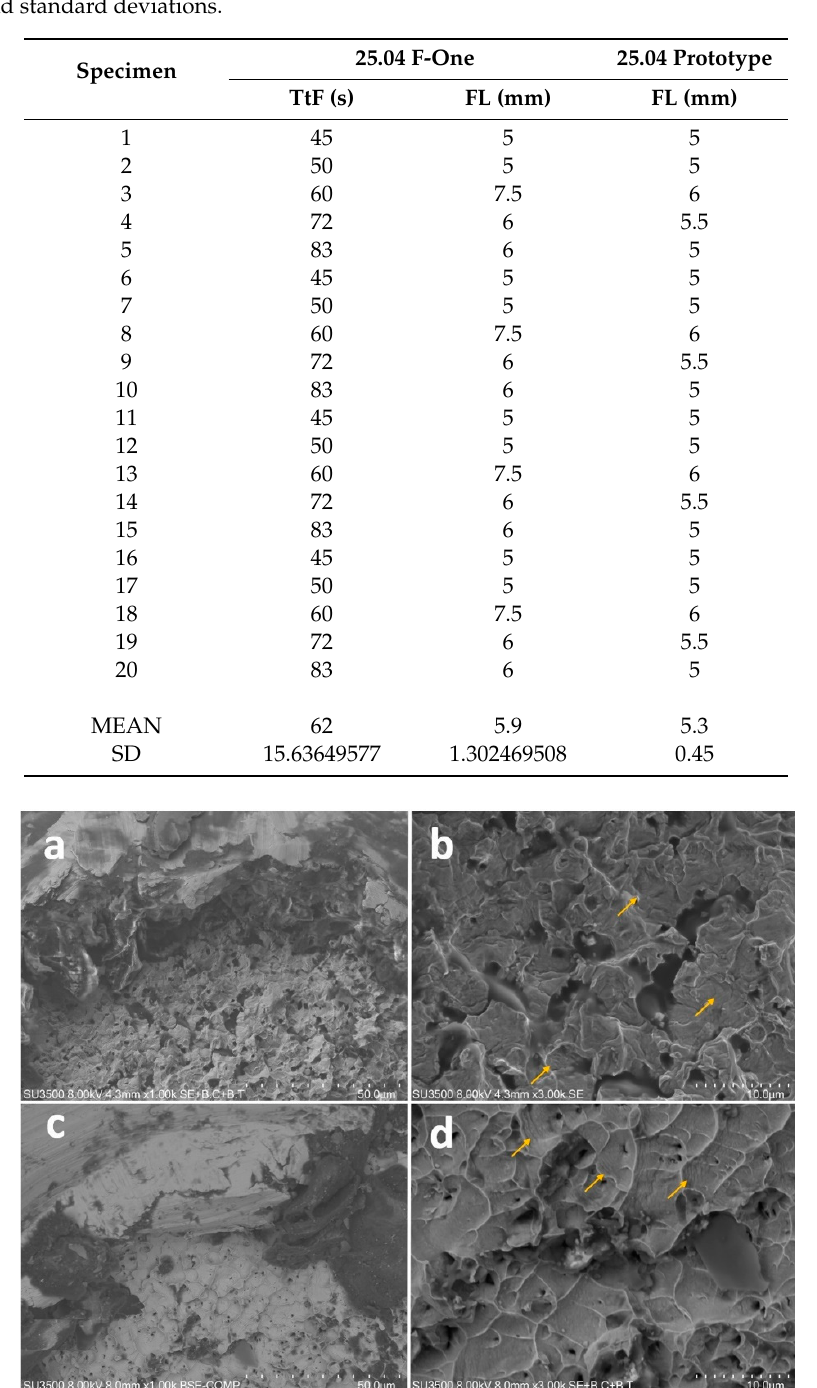
Figure 3. Microscopical aspect of the flat-designed ( a , b ) and prototype ( c , d ) fractured surface at different FE-SEM magnifications. Yellow arrows indicate fatigue striations that could be appreciated at 3000× ( b , d ).